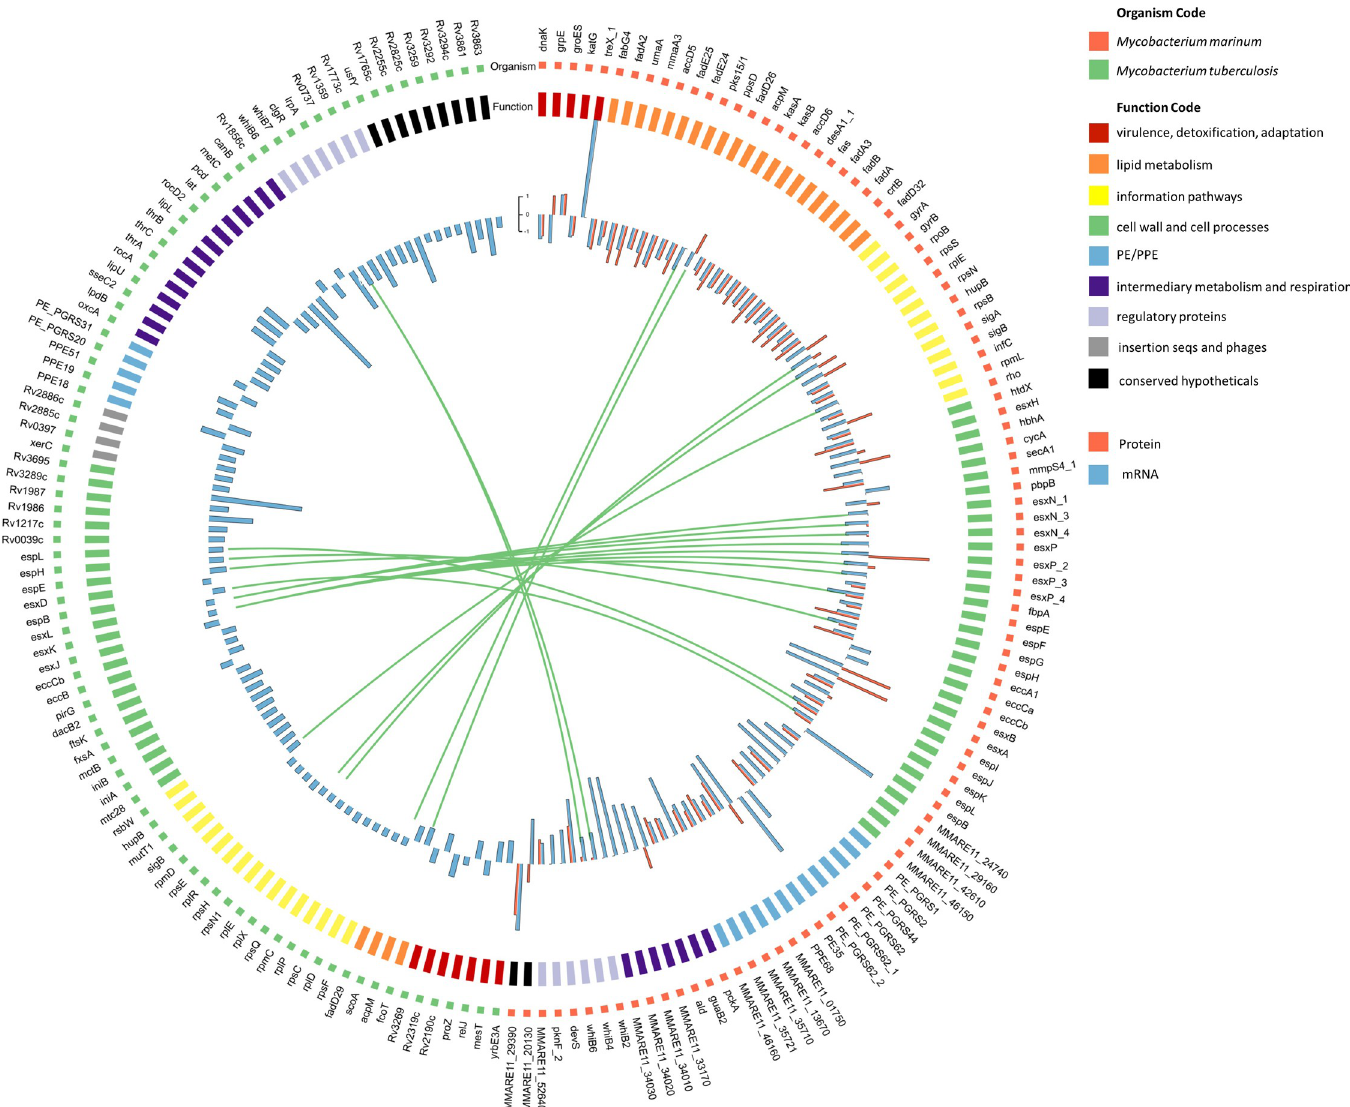
Fig 2. Top differentially expressed genes of M . marinum and M . tuberculosis , when grown in culture medium, grouped into broad functional categories. Within each group, genes are ranked in ascending order by p -value. (Red) Top 100 annotated M . marinum E11 genes that exhibit greatest differential expression in the M . marinum eccCb 1 transposon mutant compared to the isogenic wild-type strain E11 during growth in 7H9 culture medium. Bar chart of log2-fold change for individual genes (RNA, blue; protein, red; locus tags, outer). (Green) Top 100 annotated M . tuberculosis genes that exhibit greatest differential expression in the auxotrophic M . tuberculosis RD1 deletion mutant strain mc 2 6030 compared to the isogenic control strain mc 2 6020 during growth in 7H9 culture medium. Bar chart of log2-fold change for individual genes. The genes rv3872-rv3878 are not included as these genes are deleted in the RD1 mutant strain.